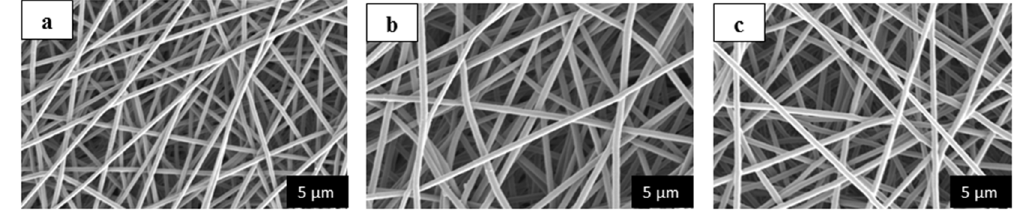
Figure 9. SEM images of the optimum condition experiment ( a ) and two different needle sizes: ( b ) 22 G and ( c ) 24 G under optimum condition.